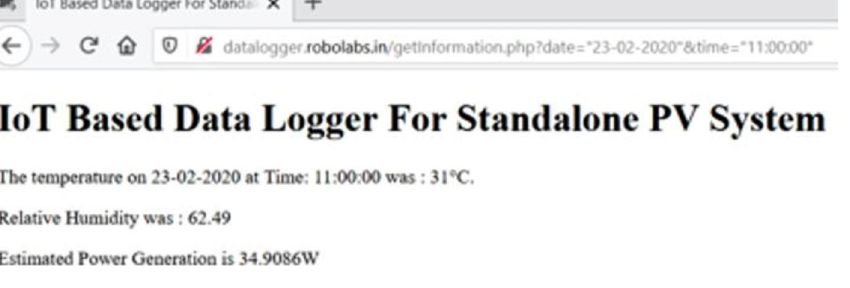
Figure 22: Website displaying estimated